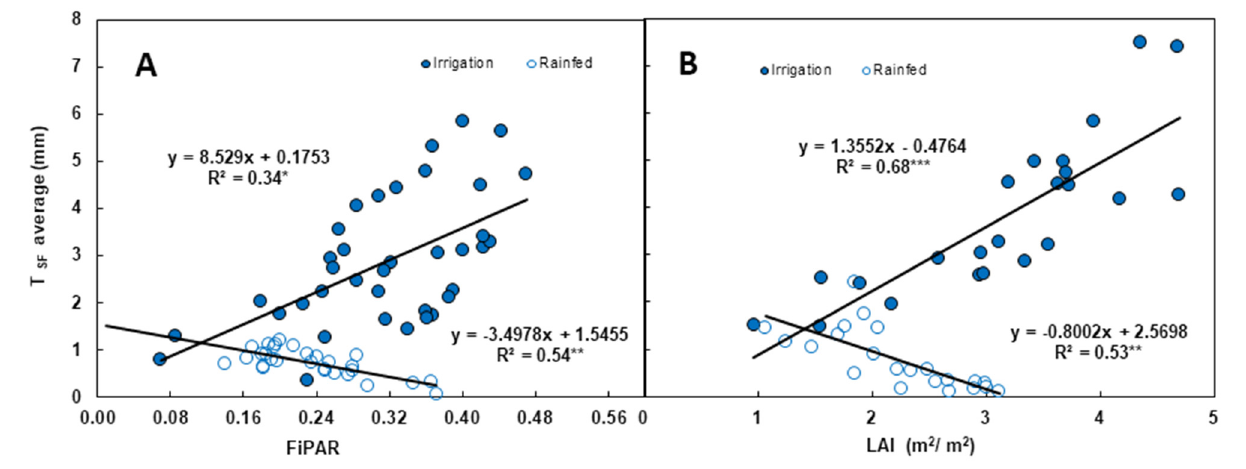
Figure 8. Relationship between transpiration with sap flow sensors (T SF ) and FiPAR and LAI during the vegetative period corresponding to the years 2012, 2013, 2014, and 2015 in non-water-limiting conditions and rainfed conditions. The relationship was fitted to a simple linear model with the number of values (n) for graph ( A ): irrigation treatment (n = 36), Rainfed treatment (n = 30); and for graph ( B ): Irrigation treatment (n = 23), rainfed treatment (n = 22). *, ** and *** indicate that the factor was significant at p < 0.05, p < 0.01 and p < 0.001, respectively.